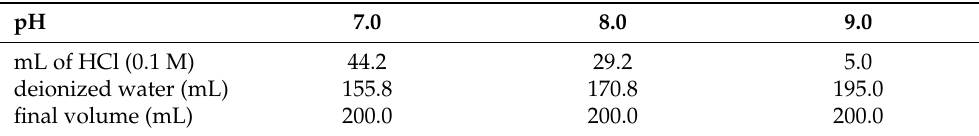
Table 2. Final volumes needed to achieve basic buffers after making 50 mL of Tris(hydroxymethyl) aminomethane (0.1